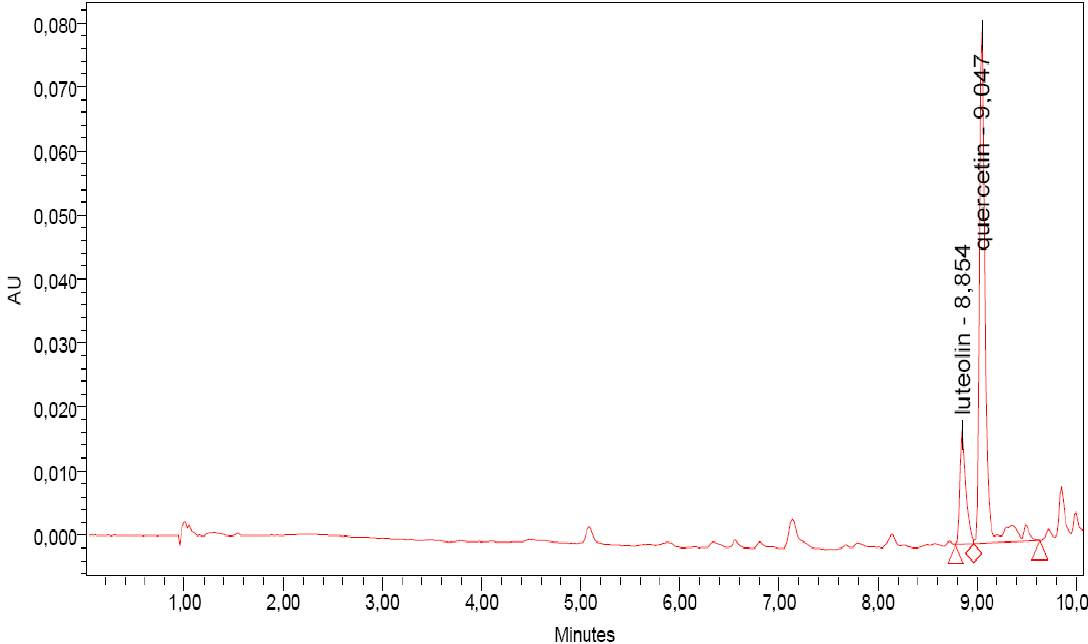
Figure 1. UPLC chromatogram of the essential oil of M. oleifera. For details, see